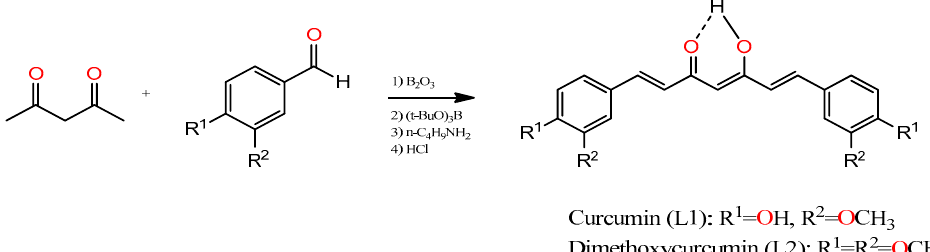
Figure 1. Synthesis of curcumin (L1) and dimethoxycurcumin